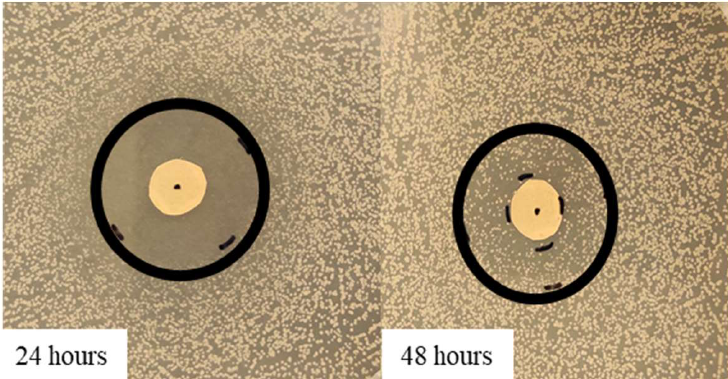
Figure 6. Variation of the inhibition halo diameter, from 24 to 48 h of incubation, for the disk volat- ilization test in the presence of 100% thyme EO against S. epidermidis .